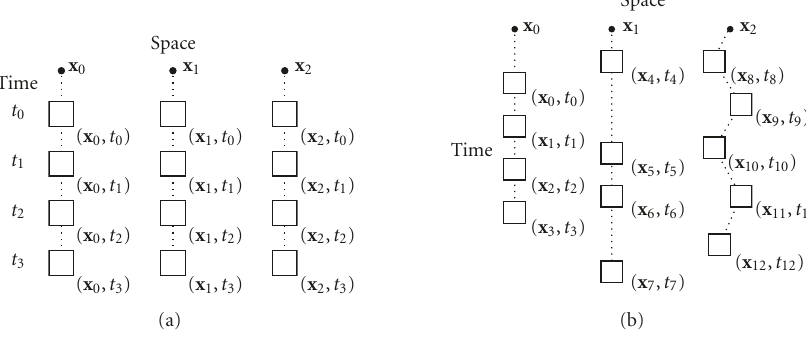
Figure 1: Comparison of a traditional array sampling scheme with the more complex model introduced in Definition 1 (each box represents a single space-time sample). (a) Traditional array: a uniform grid of space-time samples formed from the Cartesian product of time and space sampling; (b) Space-time sampler: treating each space-time sample individually allows traditional uniform sampling ( x 0 ), nonuniform asynchronous sampling ( x 1 ), and moving sensors ( x 2